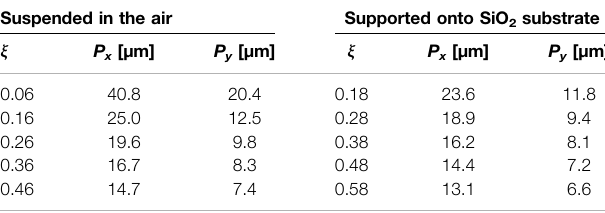
TABLE 1 | Geometrical parameters for GCWA associated with Figure 1